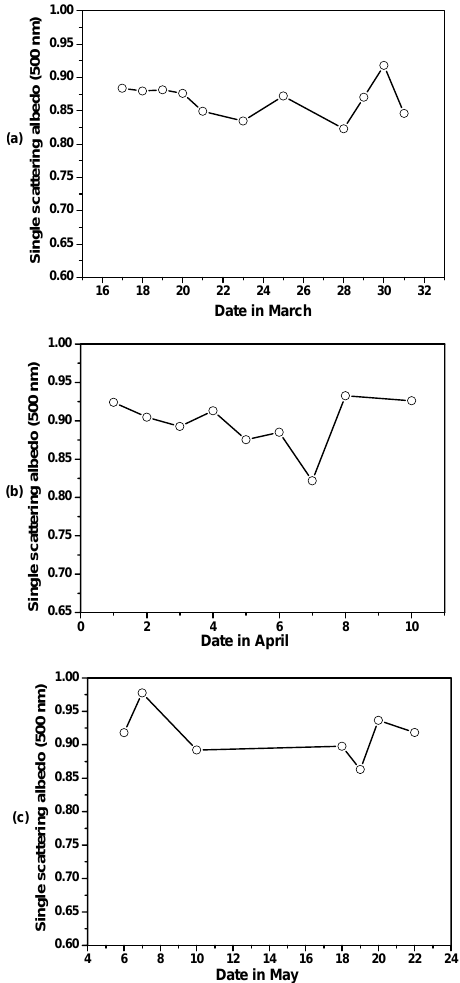
Fig. 5. Daily averaged SSA (after being adjusted) at 500nm in March (a) , April (b) and May (c) .